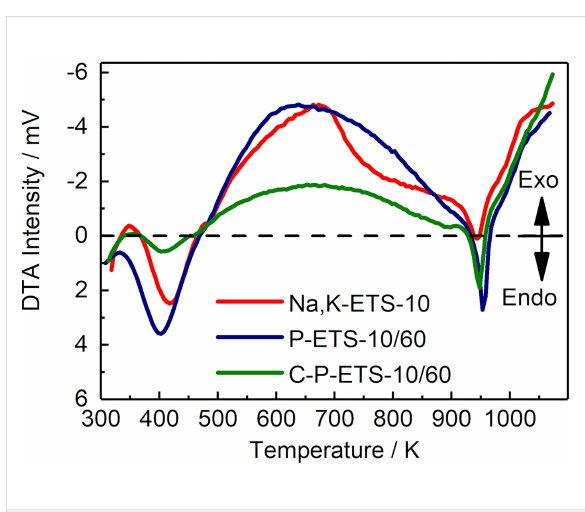
Figure 11: Differential thermal analysis of the Na,K-ETS-10 (red), P-ETS-10/60 (blue) and C-P-ETS-10/60 (green) materials. The dashed line separates regions of exothermic (exo) and endothermic (endo)